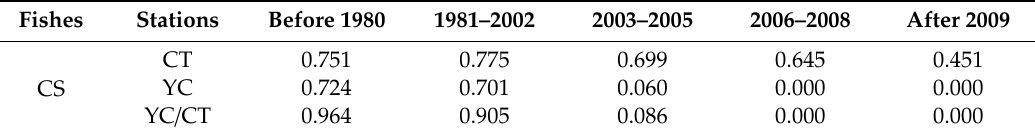
Table 3. Satisfying degree of SSC for Chinese sturgeon during di ff erent